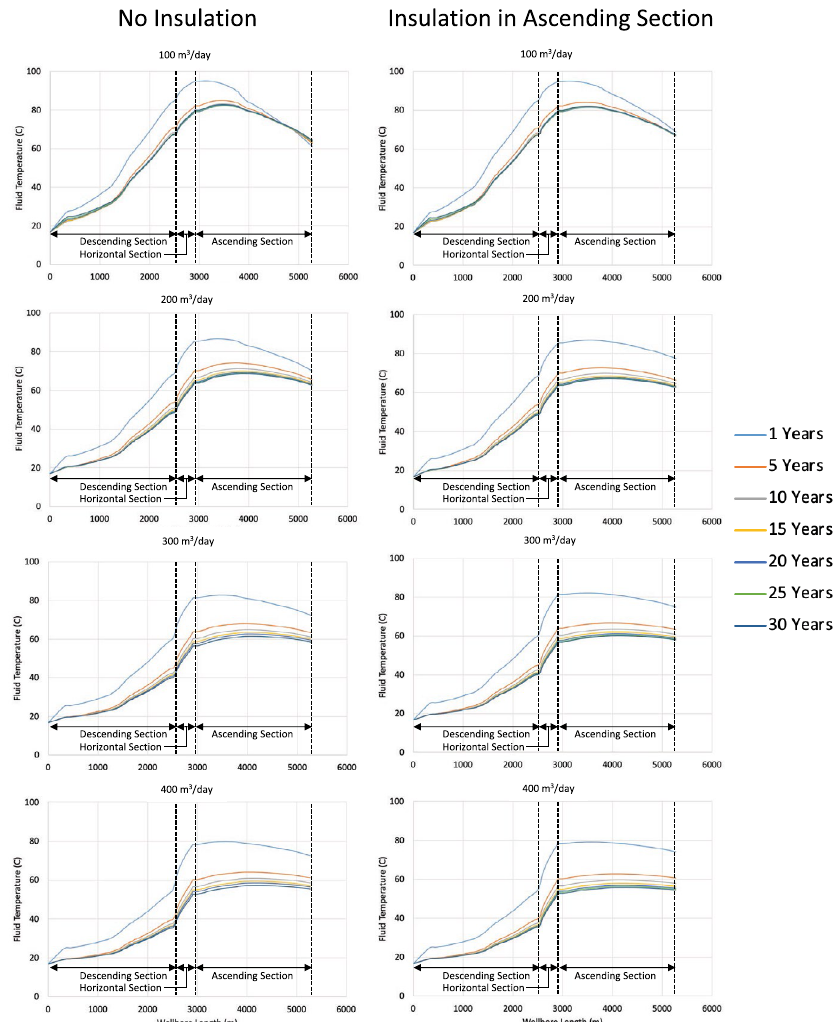
Fig. 5 Fluid temperature profiles versus path length versus flow rate and time in the case of no